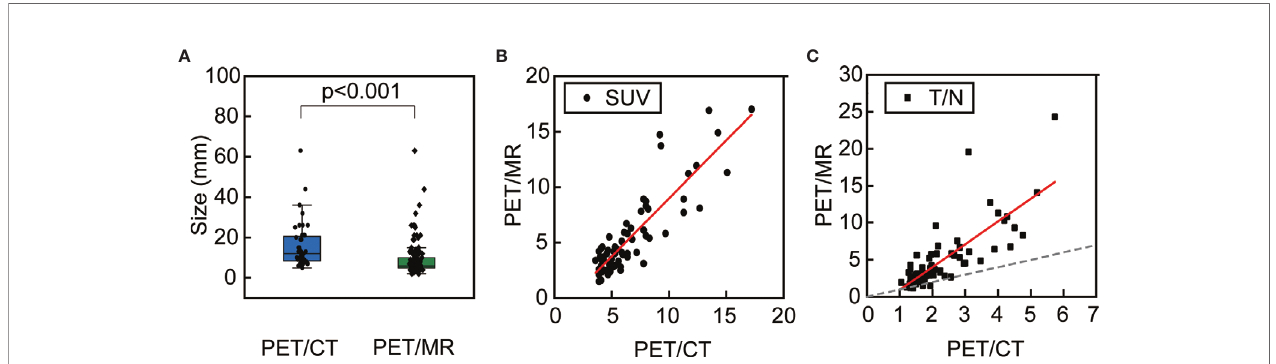
FIGURE 3 | The box plot of the sizes of all metastases detected by PET/CT and PET/MR (A) ; the relationship of the SUVmax of the same lesion detected by PET/ CT and PET/MR (B) and the relationship of the T/N of the same lesion detected by PET/CT and PET/MR, where the dashed line indicates equal T/N (C) .